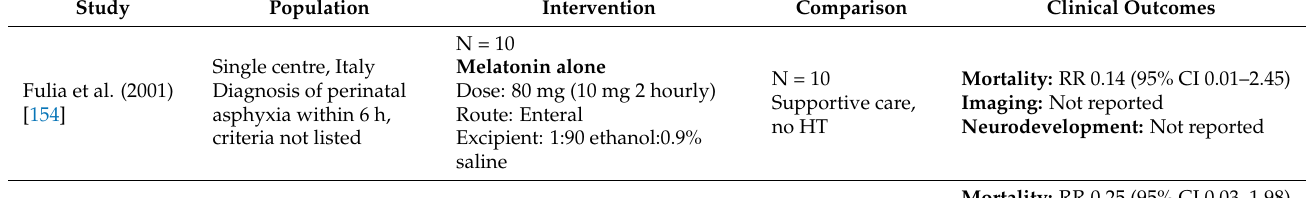
Table 3. Randomised clinical trials using melatonin for neonatal encephalopathy in infants and relevant clinical outcomes. Study Population Intervention Comparison Clinical